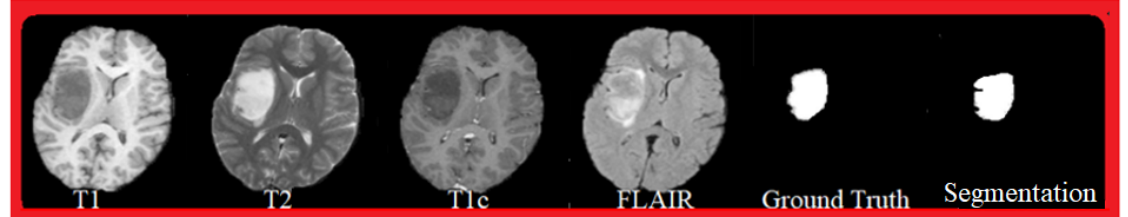
Figure 4. MRI sequences of brain tumors: FLAIR, T1, T1 contrasted by Gadolinium injection, T2, and Ground Truth superimposed on the FLAIR sequence.